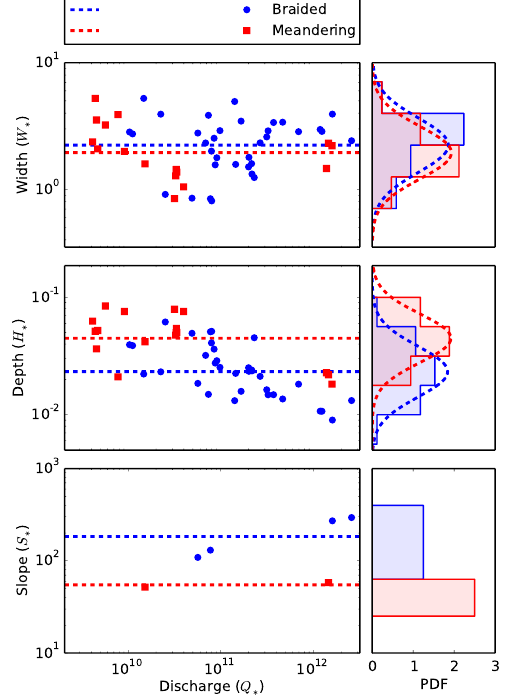
Figure 8. Left: dimensionless width ( W ∗ ), depth ( H ∗ ) and slope ( S ∗ ) of the Kosi fan threads as functions of the dimensionless water discharge ( Q ∗ ). Dashed blue and red lines indicate averages. Right: corresponding probability density